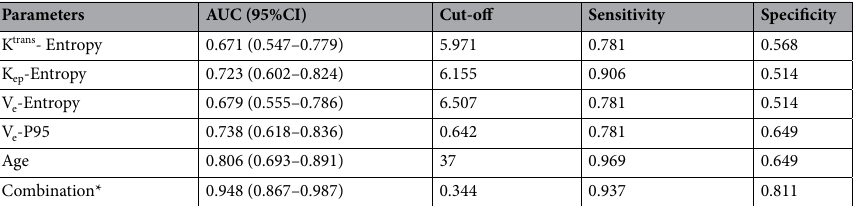
Table 4. ROC analyses of texture-derived parameters in differentiating between thymic carcinoma and lymphoma groups. *Combination represents the combination of age, K trans -Entropy, K ep -Entropy, V e -Entropy, and V e